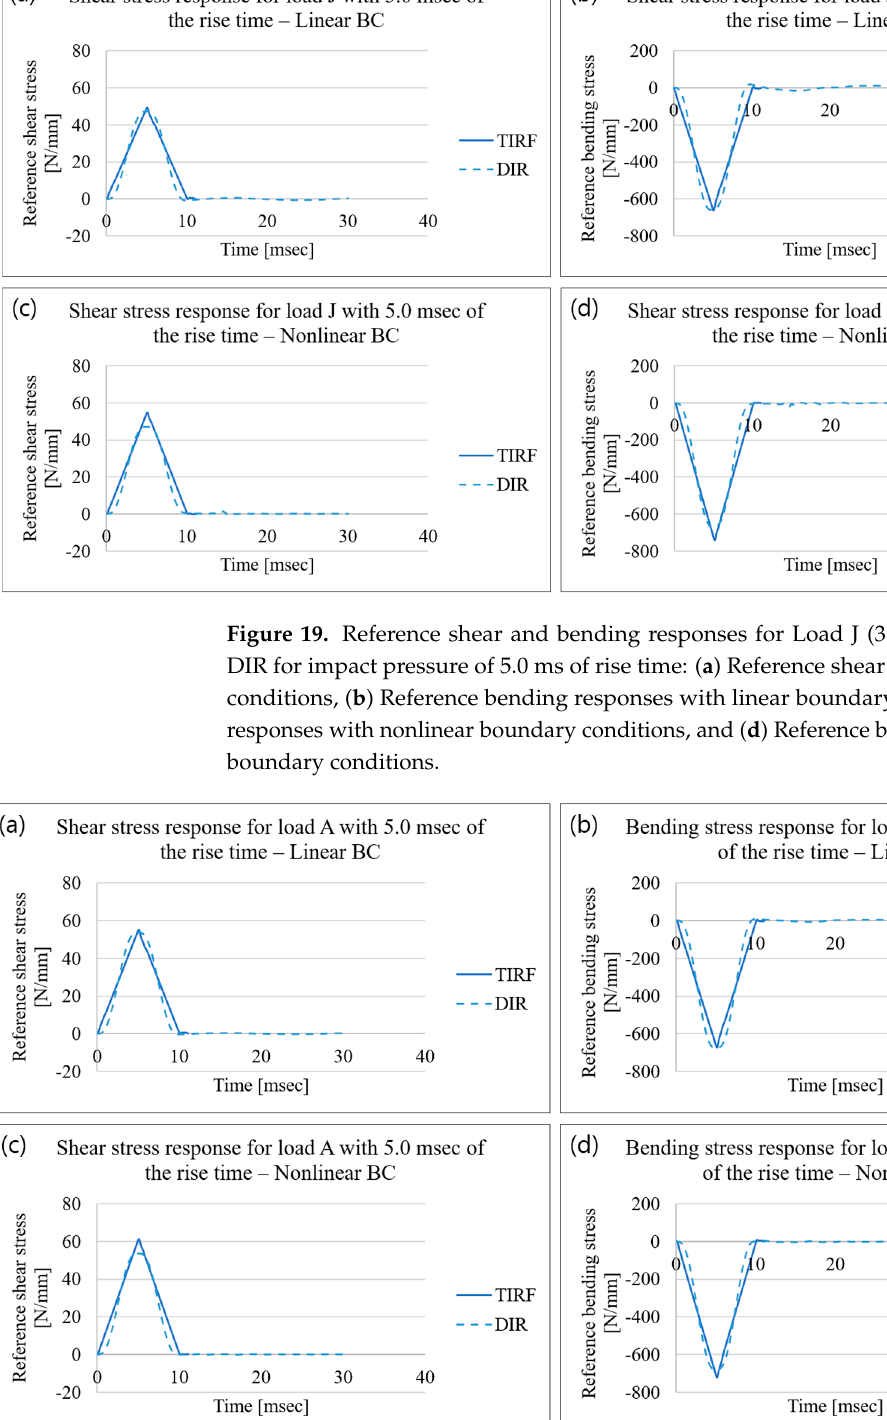
Figure 20. Reference shear and bending responses for Load A (1 × 1 load case) using TIRF and DIR for impact pressure of 5.0 ms of rise time: ( a ) Reference shear responses with linear boundary conditions, ( b ) Reference bending responses with linear boundary conditions, ( c ) Reference shear responses with nonlinear boundary conditions, and ( d ) Reference bending responses with nonlinear boundary conditions.